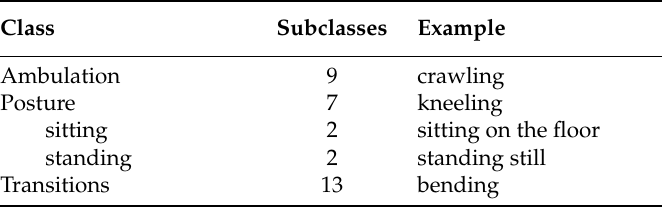
Table 3. Physical state classes in the SPHERE ADL ontology.